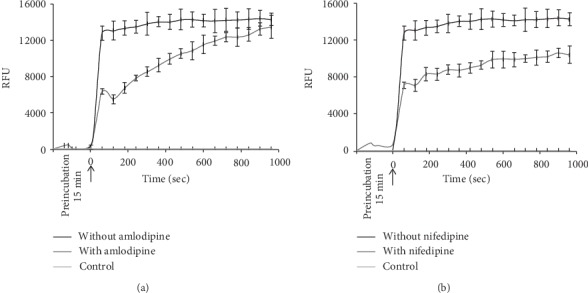
The effect of L-type calcium ion channel antagonists on evoked by compound Ca2+ ion channel activity. (a) The effect of amlodipine on evoked by compound 4 Ca2+ ion channel activity. (b) The effect of nifedipine on evoked by compound 4 Ca2+ ion channel activity. Fura-4 NW loaded SH-SY5Y cells were preincubated with amlodipine and nifedipine in the 100 μM concentration for 15 min, and thereafter, the cells were stimulated (arrow) by the addition of compound 4 (concentration 100 μM). Control is Fura-4 NW loaded cells without stimulator. Values were presented in RFU (relative fluorescence units) ± SD.